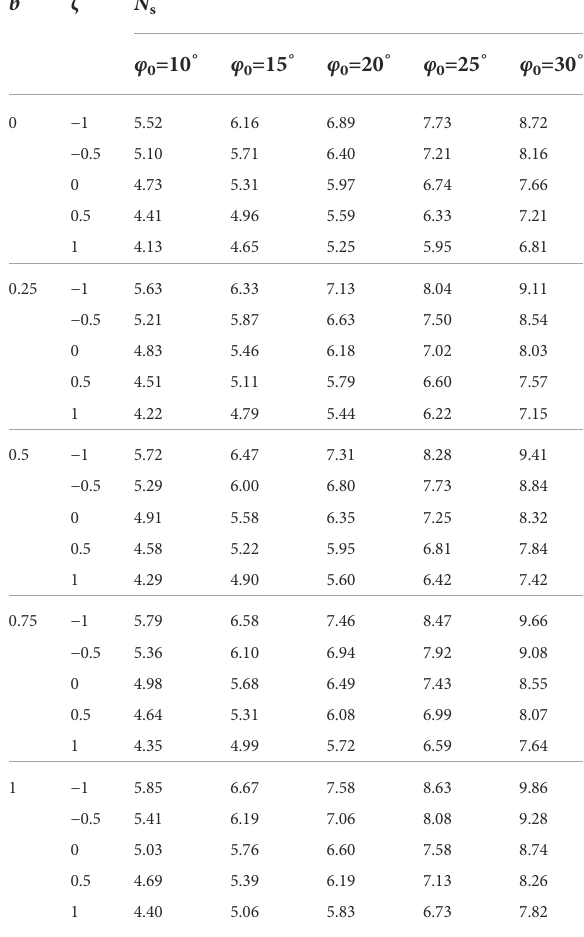
TABLE 5 Stability factor with different ζ ( k h =0.2, β =70 °